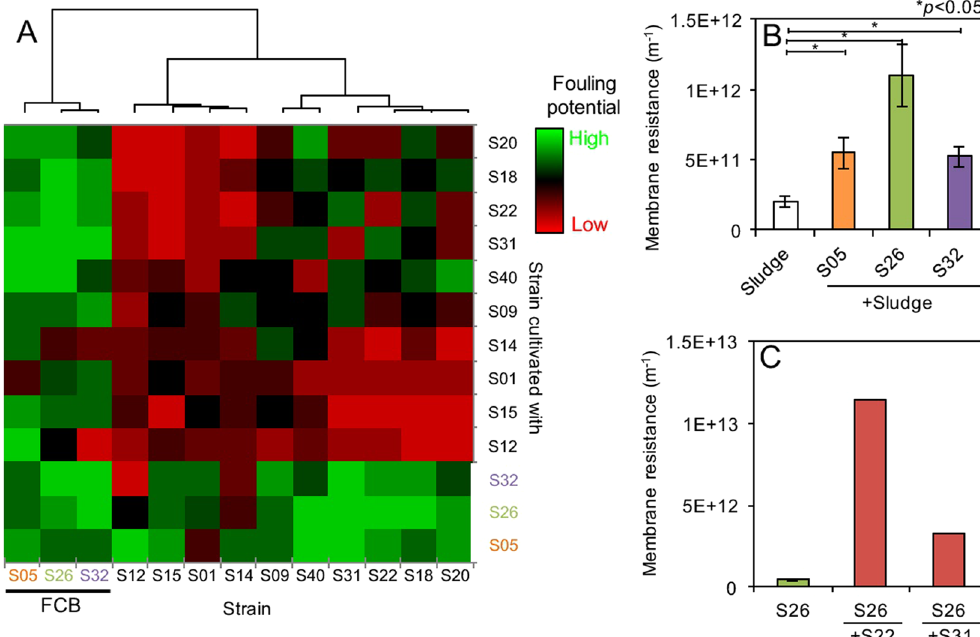
Figure 2. ( A ) Fouling potential of co-culture of 13 isolated strains (in total 78 combinations). ( B ) Effect of FCB (S05, S26, and S32) addition to activated sludge on fouling potential. The error bars indicate the standard deviations of two independent experiments. The bar following sign indicates statistical difference between two groups with respective p value: * P < 0.05. ( C ) Fouling potential of S26 as single-culture and co-culture with S22 or S31.